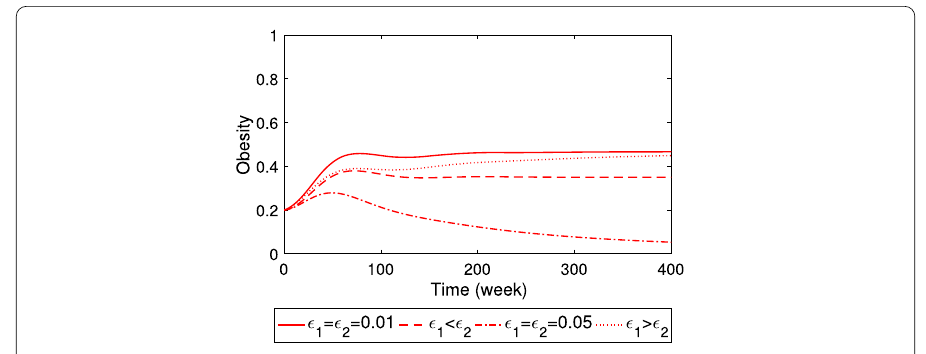
Figure 4 Obese compartment vs. time with varying ε 1 and ε 2